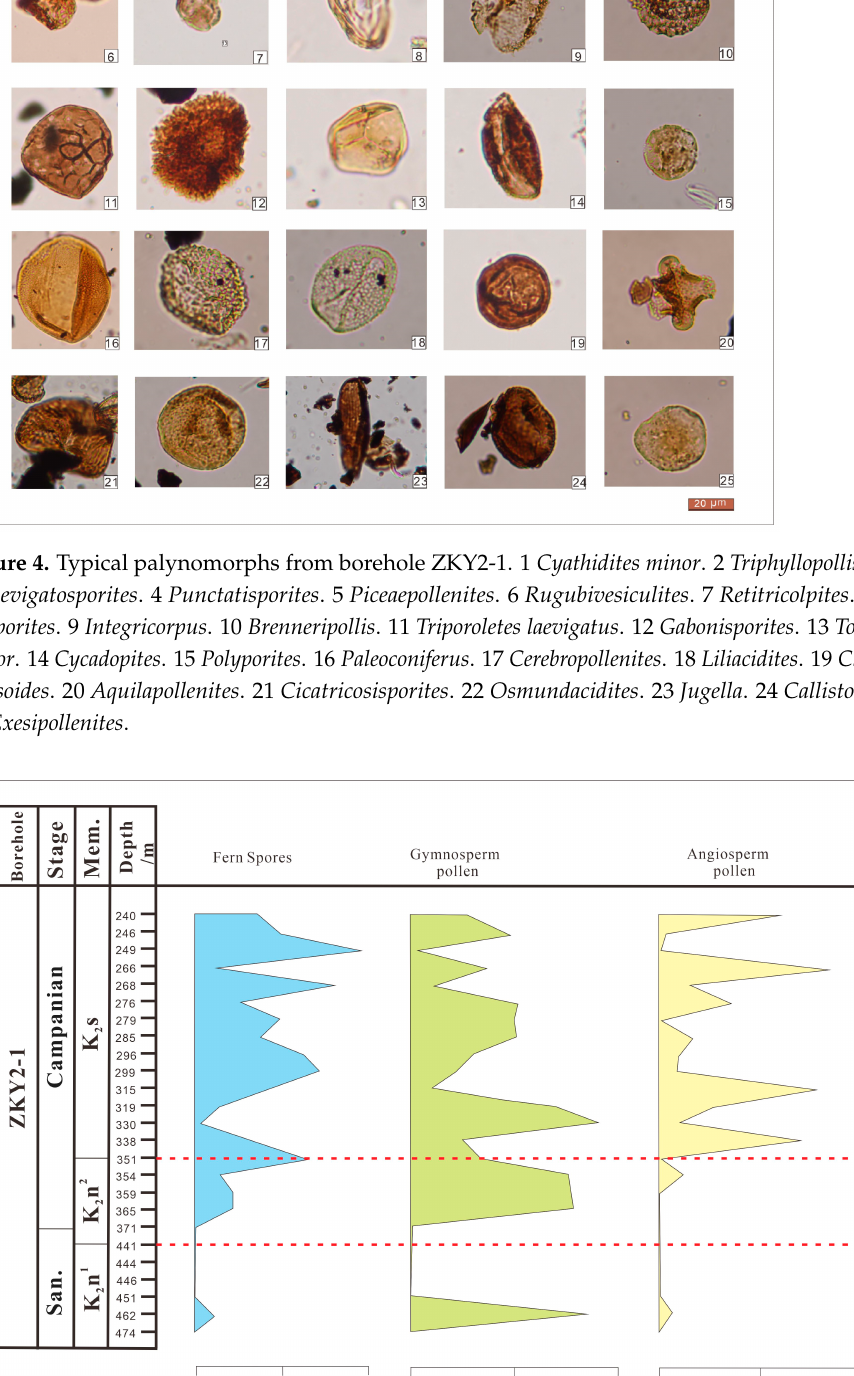
1+2 to K 2 n 2 s in borehole